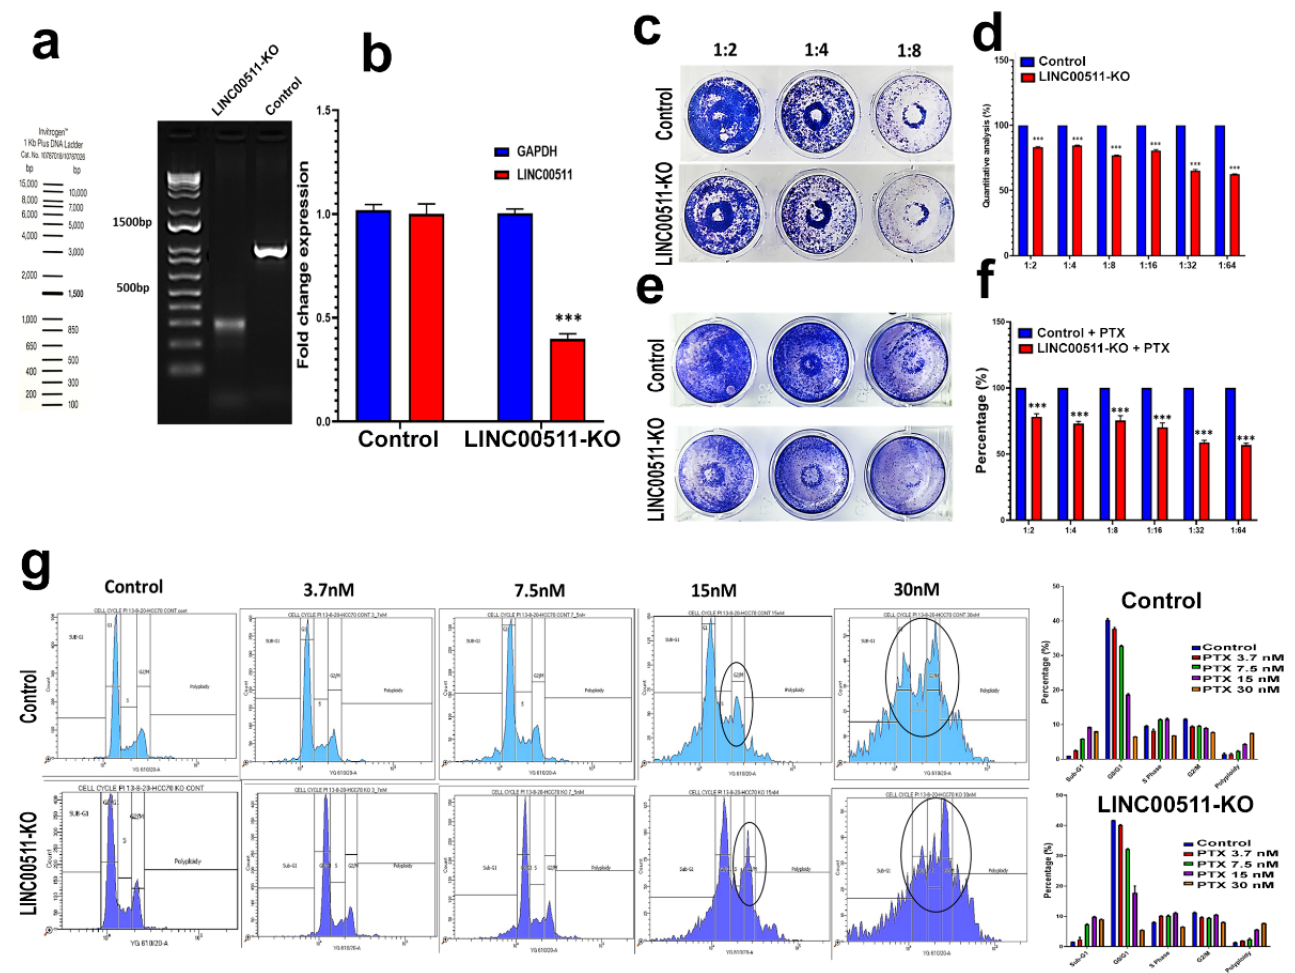
Figure 7. Effect of CRISPR-Cas9 mediated LINC00511 promoter deletion on HCC70 colony formation and paclitaxel sensitivity. ( a , b ) Genomic deletion of the LINC00511 promoter using CRISPR-Cas9 in the HCC70 TNBC model. qRT-PCR for LINC00511 expression in HCC70 WT and LINC00511-KO cell models. Data are presented as mean ± SD, n = 3. *** p < 0.0005. Clonogenic assay for HCC70 parental and LINC00511-KO cells, in the absence ( c , d ) or the presence ( e , f ) of indicated concentrations of Paclitaxel. Data are presented as mean ± SD, n = 4. *** p < 0.0005. ( g ) Cell cycle analysis for HCC70 parental and LINC00511-KO cells in the absence or presence of different concentrations of Paclitaxel. AO/EtBr viability staining also confirmed the induction of cell death in LINC00511- KO cells when combined with as low as 3.7 nM of paclitaxel (Figure